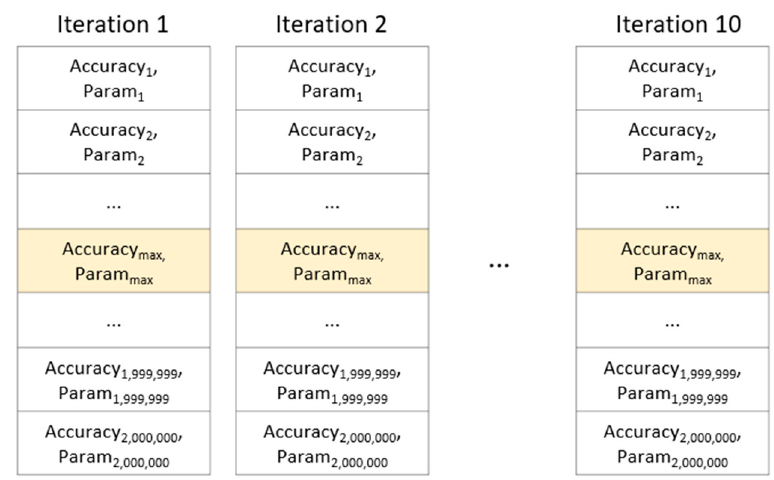
Figure 7. Recognition rate graph according to convolutional layer depth ( 𝐶𝐿𝐷 ).